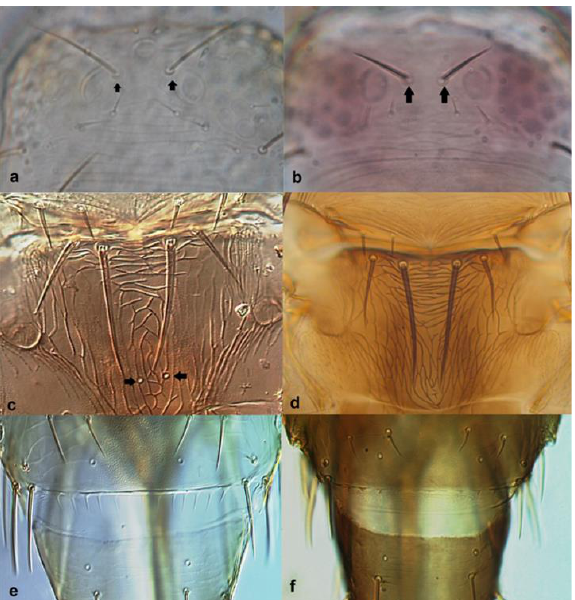
Ocellar setae iii arising close together between hind ocelli (Figure 35b); meta-thoracic campaniform sensilla absent (Figure 35d); microtrichial comb at the posterior margin of tergite VIII not developed or with few short teeth on lateral margins (Figure 35f)